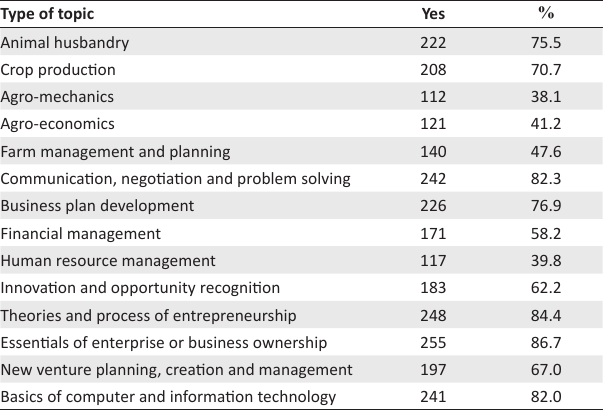
TABLE 3: Basic farm entrepreneurial competencies studied ( N =